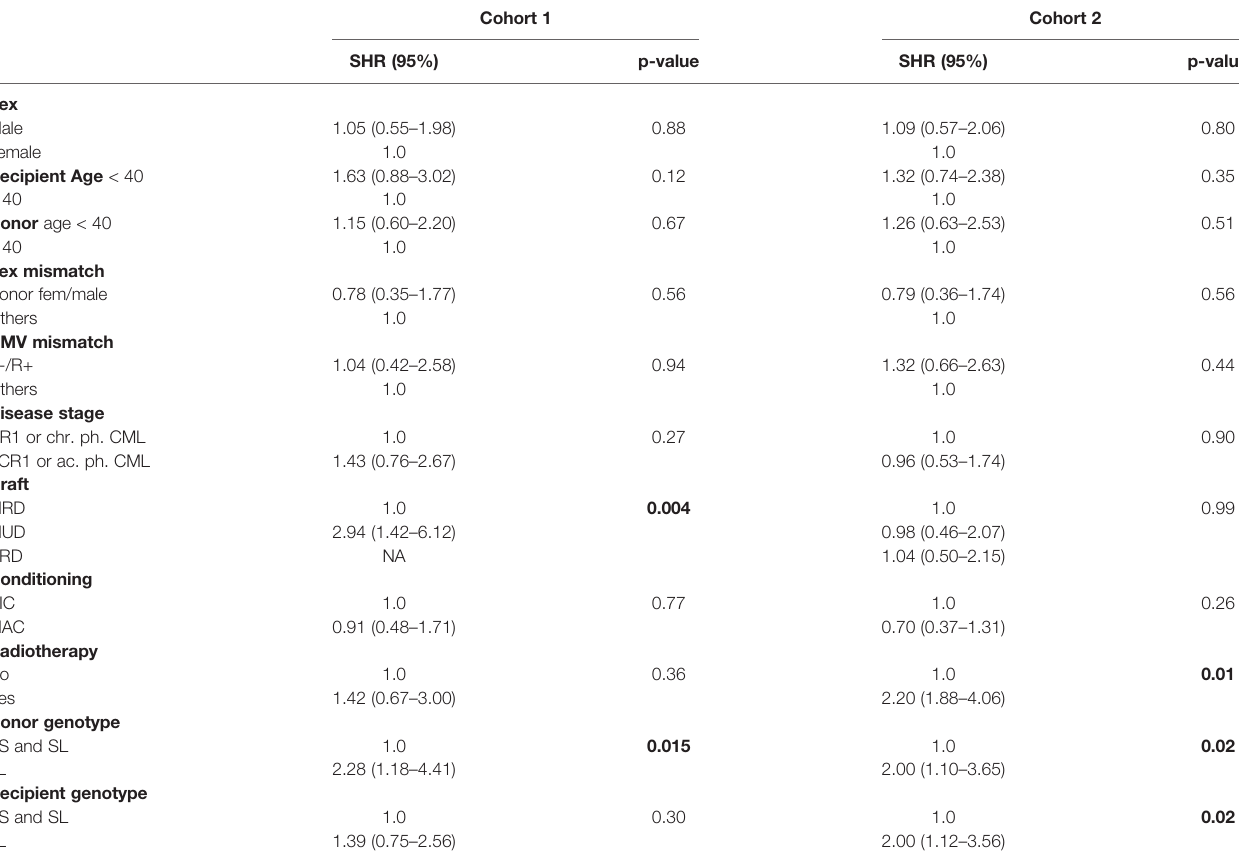
TABLE 6 | Univariate analysis of GVHD risk factors.